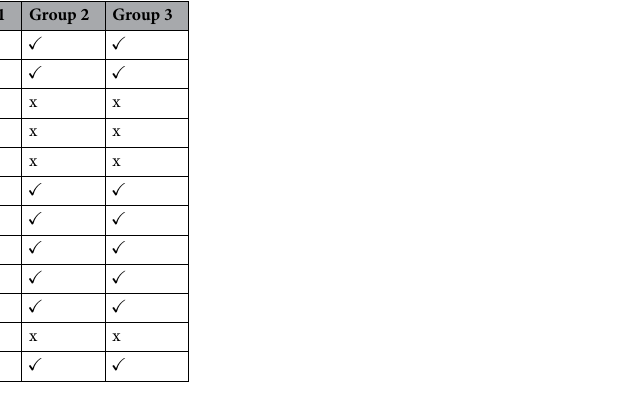
Table 3. Feature indication.